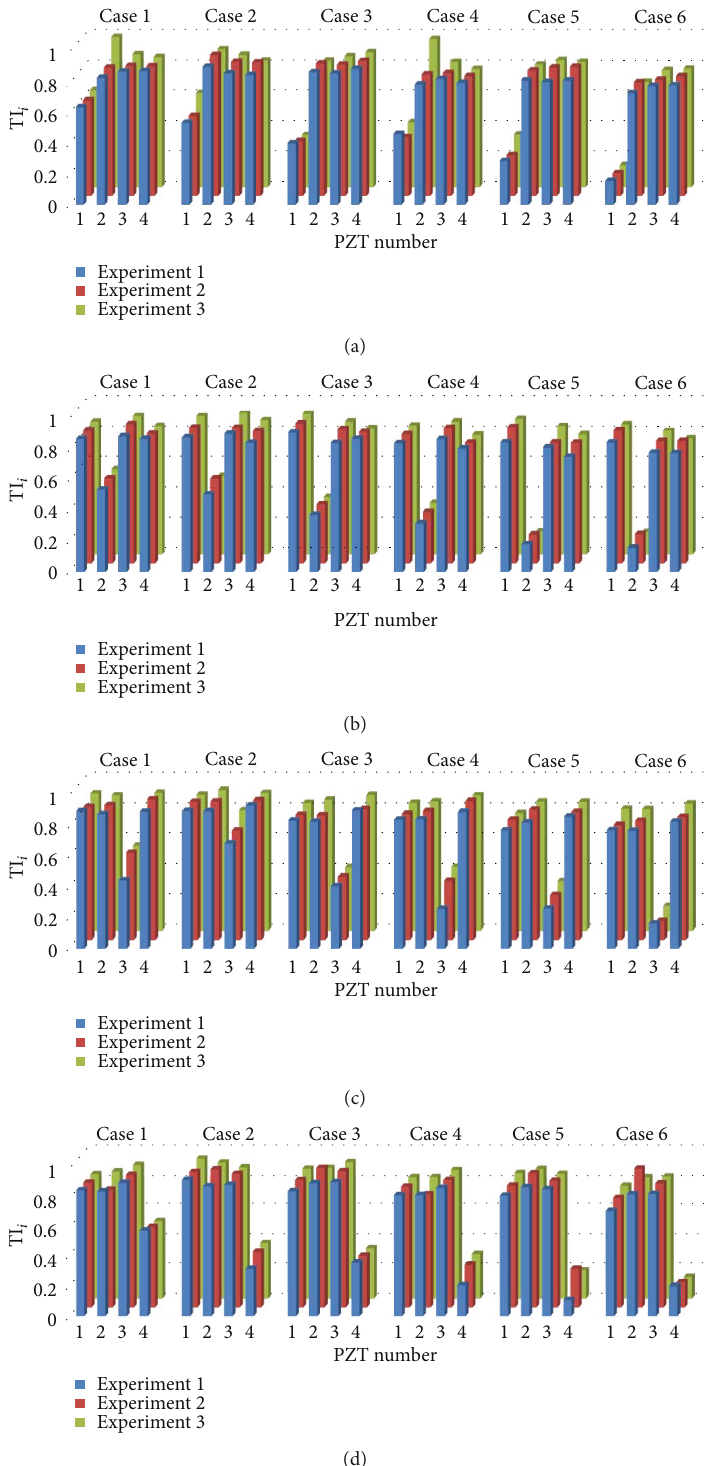
s at di ff erent bolt loosening cases: (a) results of bracket 1, (b) results of bracket 2, (c) results of bracket 3, Figure 9: The predictive variables TI i and (d) results of bracket